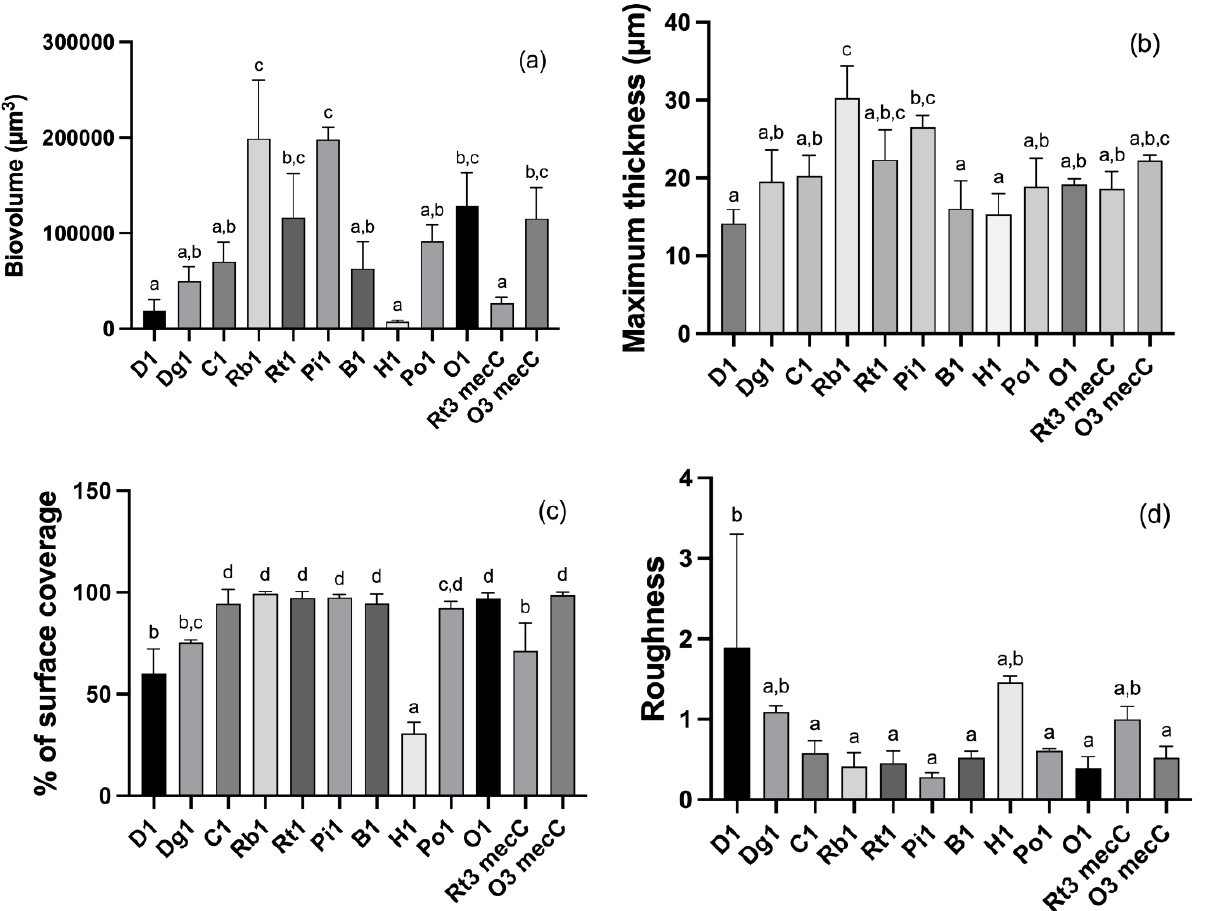
Figure 3. Biovolume in the observation field of 16,078.2 μ m 2 ( a ), maximum height ( b ), percentage of surface area covered ( c ) and roughness ( d ) of biofilms formed de 12 selected S. aureus isolates. Statistical significance was determined using Tukey’s multiple comparison test. The values marked with the same letter are not statistically significant as determined by the Tukey’s post hoc test (p < 0.05). D: donkey; Dg: dog; C: camel; Rb: rabbit; Rt: rodent; Pi: pig; B: bovine; H: hare; Po: poultry; O